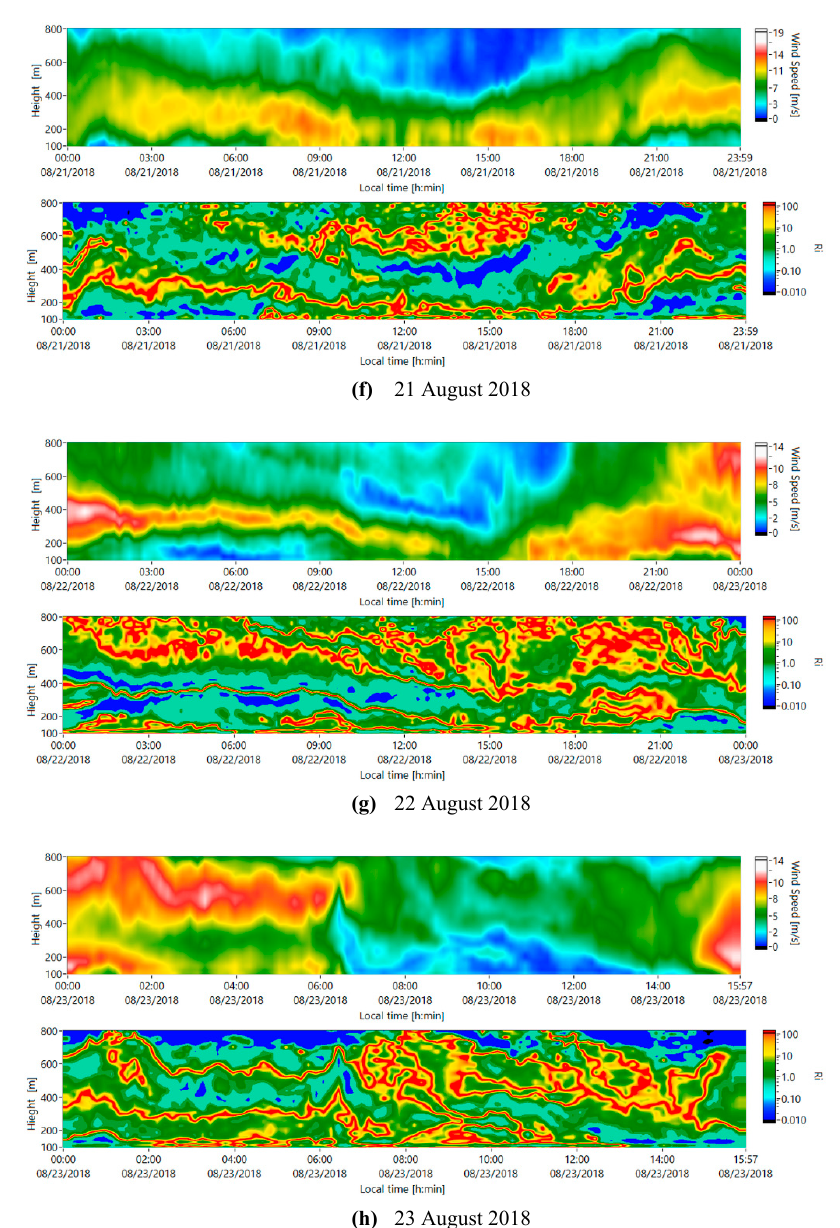
Figure 5. Spatiotemporal distributions of the wind velocity and Richardson number on ( a ) 9, ( b ) 11, ( c ) 12, ( d ) 18, ( e ) 19, and ( f – h ) 21–23 August 2018.